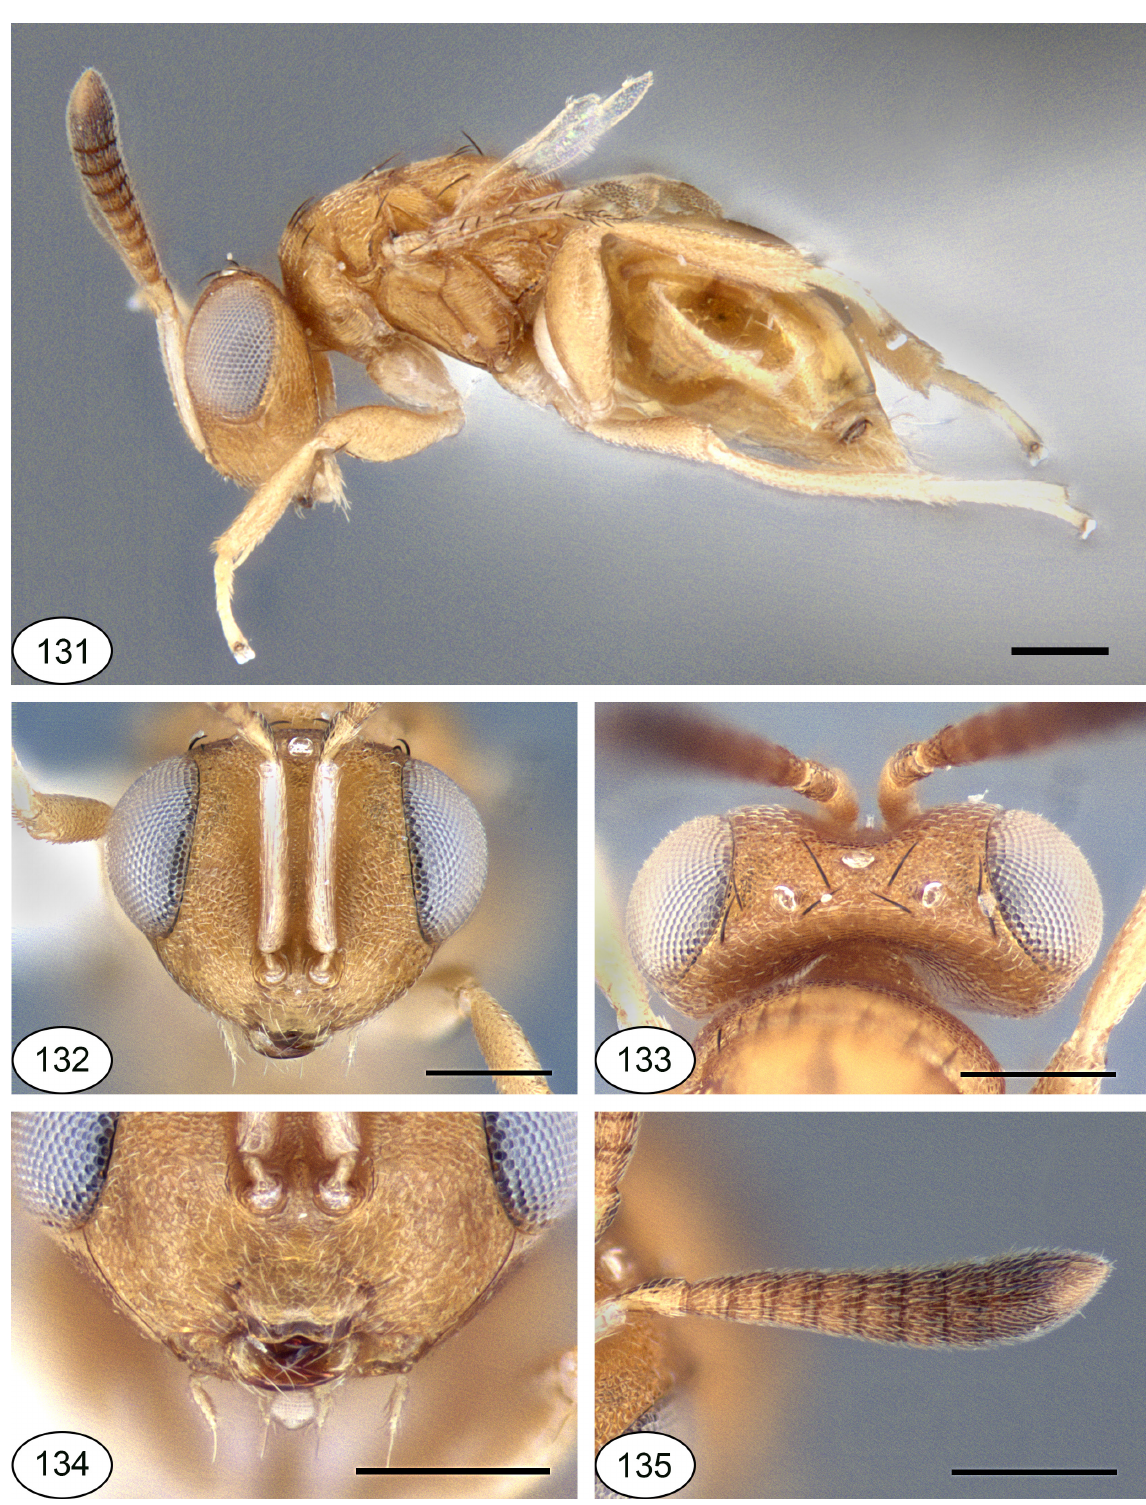
Figs 131–135. Netomocera nearctica Yoshimoto, 1977, ♀, Missouri (USA). 131 . Habitus, lateral view. 132 . Head, frontal view. 133 . Head, dorsal view. 134 . Lower face. 135 . Antenna. Scale bars: 0.2